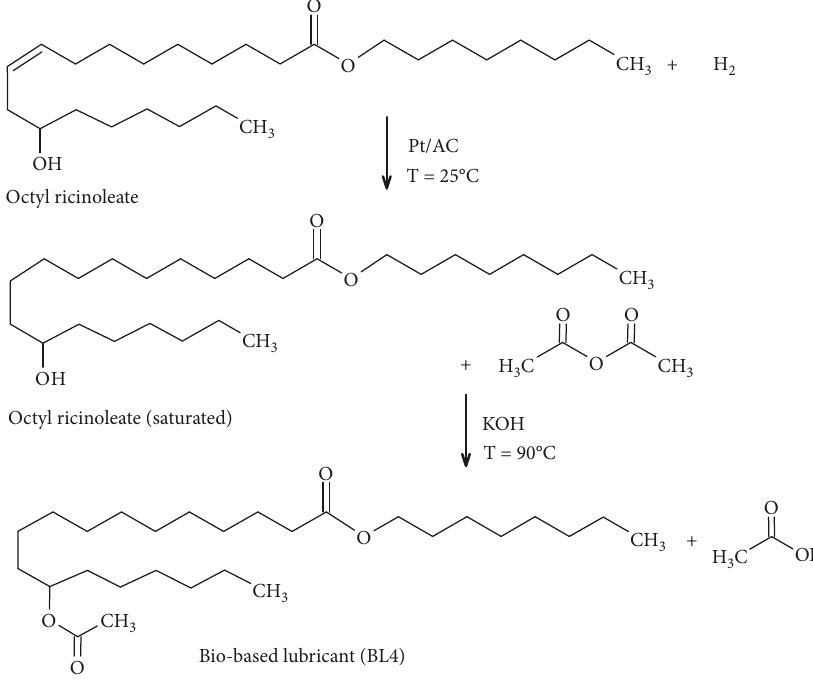
Figure 5: Synthetic route for the bio-based lubricant